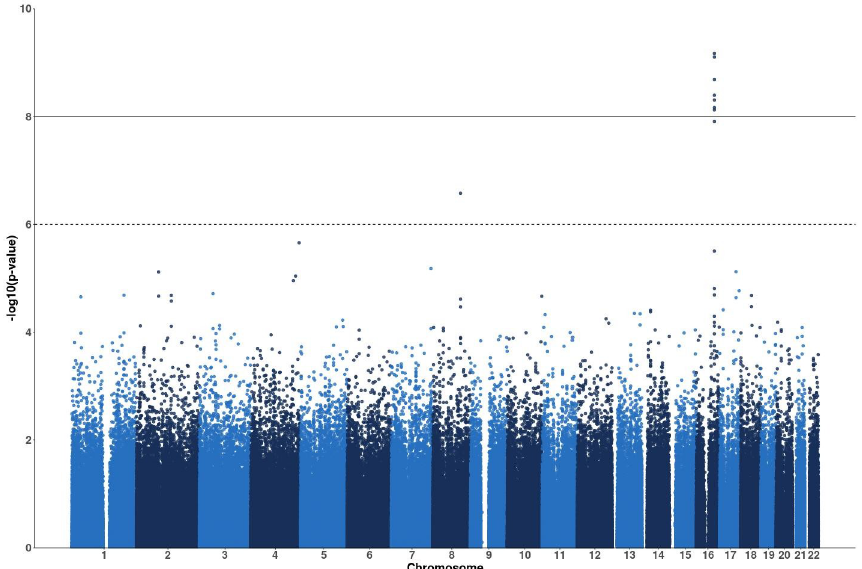
Fig 1. Manhattan plot of MAGWAS p-values for the drug erlotinib. Manhattan plot of MAGWAS -log 10 (p-value) over 22 autosomes for the association of genotype and cell viability for the drug erlotinib. The dashed and solid lines indicate the thresholds for the genome-wide suggestive significance level of 10 − 6 and the genome-wide significance level of 10 − 8 , respectively. The peak on chromosome 16 has seven SNPs surpassing the genome-wide significance level (the solid horizontal line), including the SNPs rs12447326 and